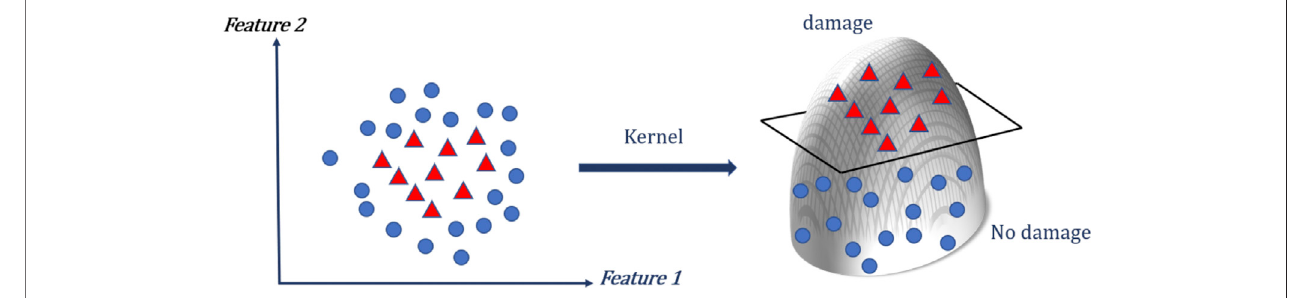
FIGURE 6 | Support Vector Machine illustration of projection of 2D data into a higher dimension through kernel function